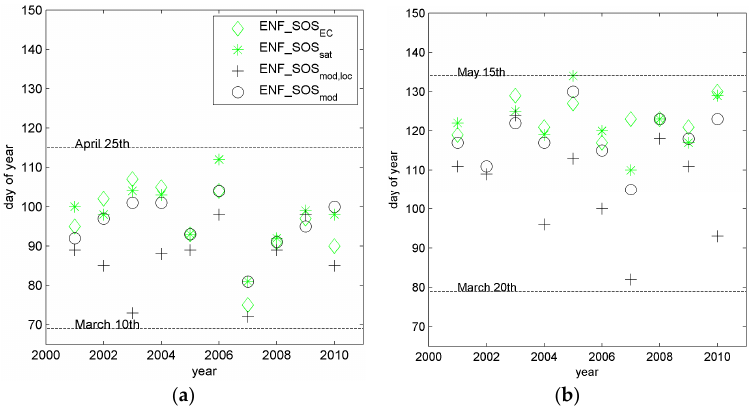
Figure 3. Comparison of the start of season in evergreen needle-leaf forest determined from eddy covariance measurements (ENF_SOS EC ) and satellite observations (ENF_SOS sat ), together with JSBACH model-derived dates for 2001 to 2010 in ( a ) Hyytiälä, southern Finland and ( b ) Sodankylä, northern Finland. The start of season from JSBACH was determined from model runs using both REMO-generated bias-corrected meteorological data (ENF_SOS mod ) and local site observations (ENF_SOS mod,loc ). Table 3. Start of season in evergreen needle-leaf forest for the period 2001–2010 at Hyytiälä and Sodankylä as defined from CO 2 flux measurements (ENF_SOS EC ) and based on JSBACH model simulations with local (ENF_SOS mod,loc ) and regional driving data (ENF_SOS mod ). A negative bias means that the simulated date is early compared to